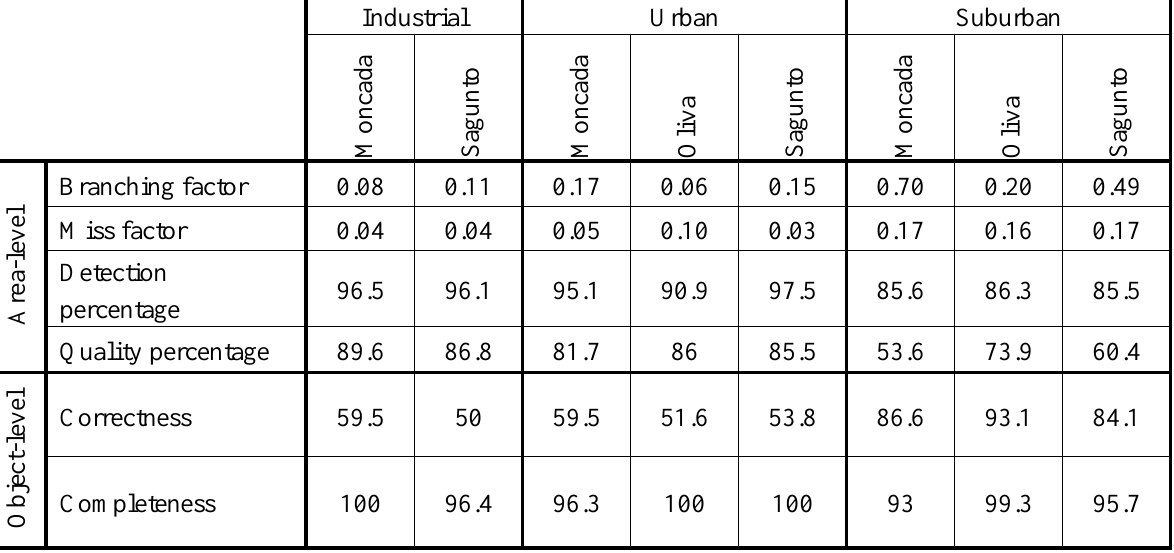
Table 4. Results of building detection applying the object-based classification method.